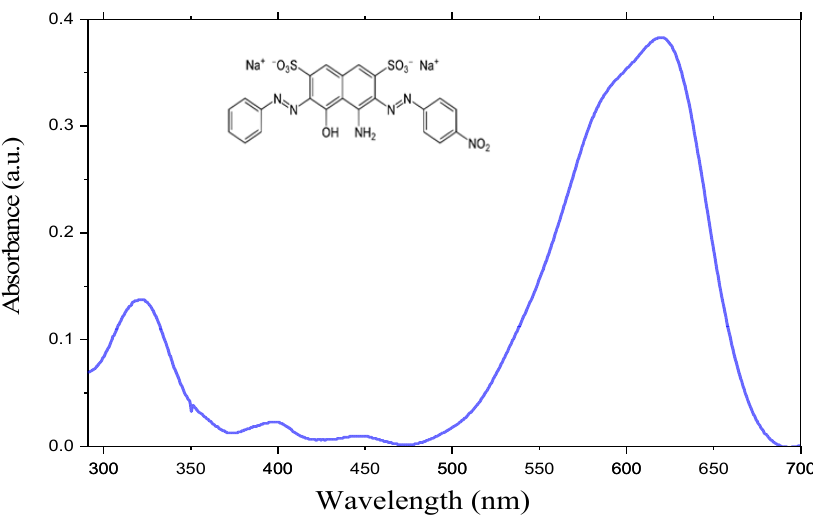
Figure 10. UV–Visible spectra of the Figure 10 . UV–Visible spectra of the BA-dye . Figure 10 . UV–Visible spectra of the BA-dye .